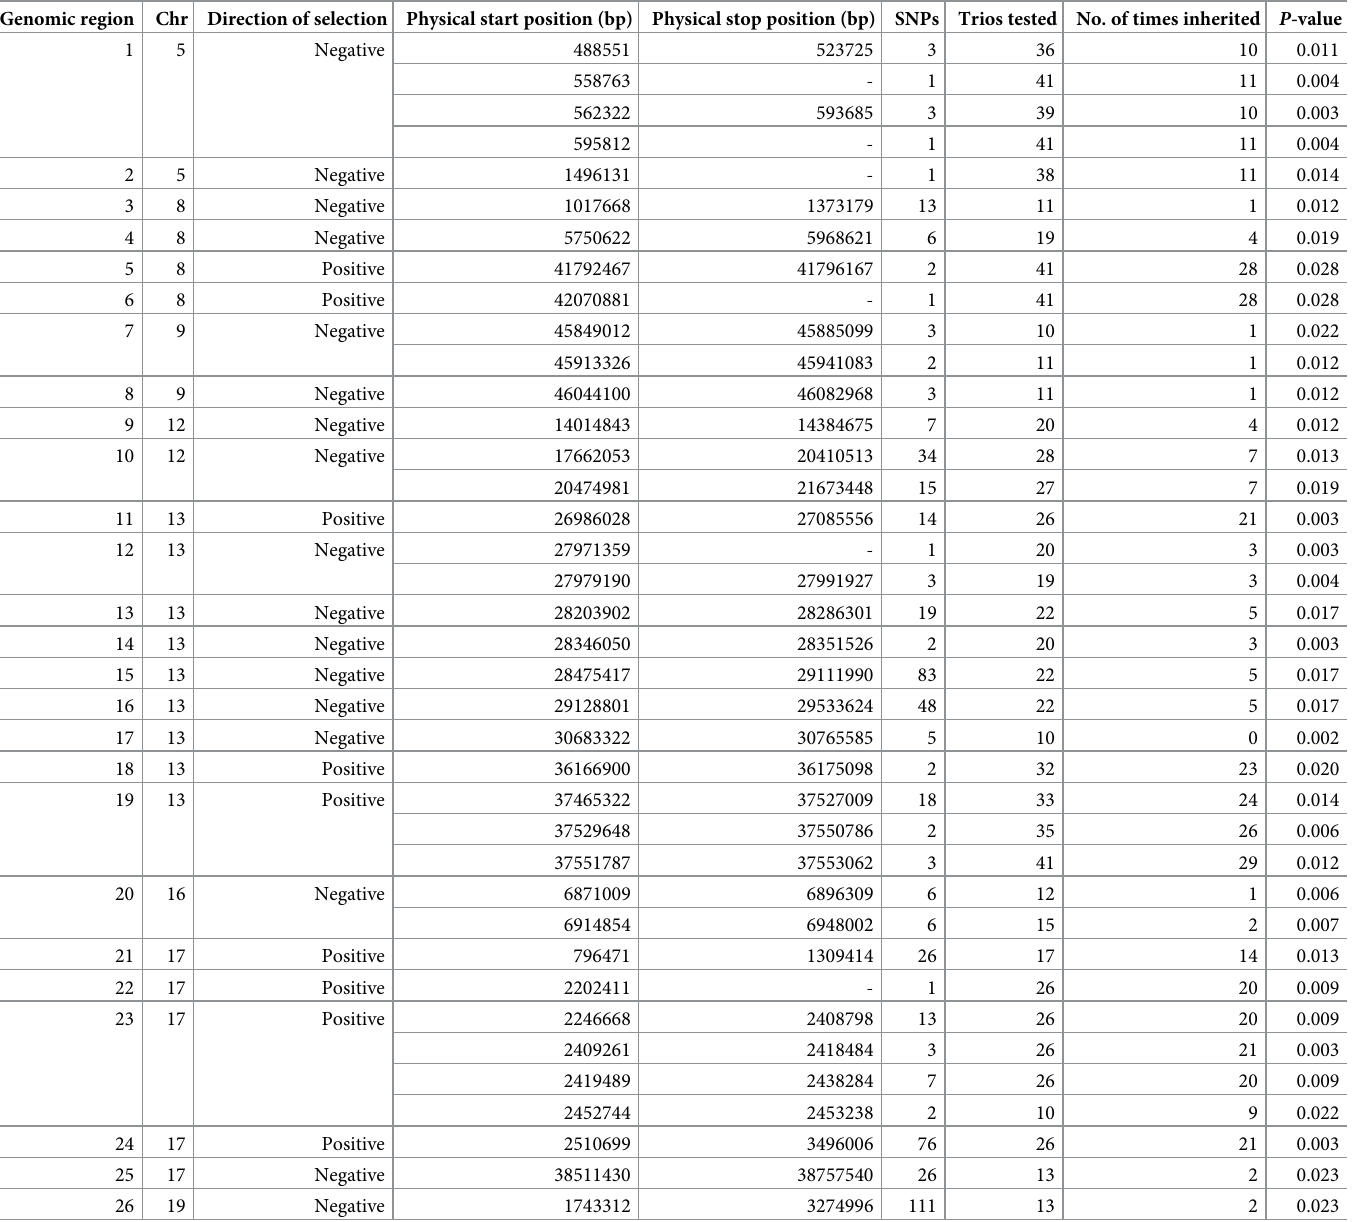
Table 2. Summary of PI 416937 pedigree